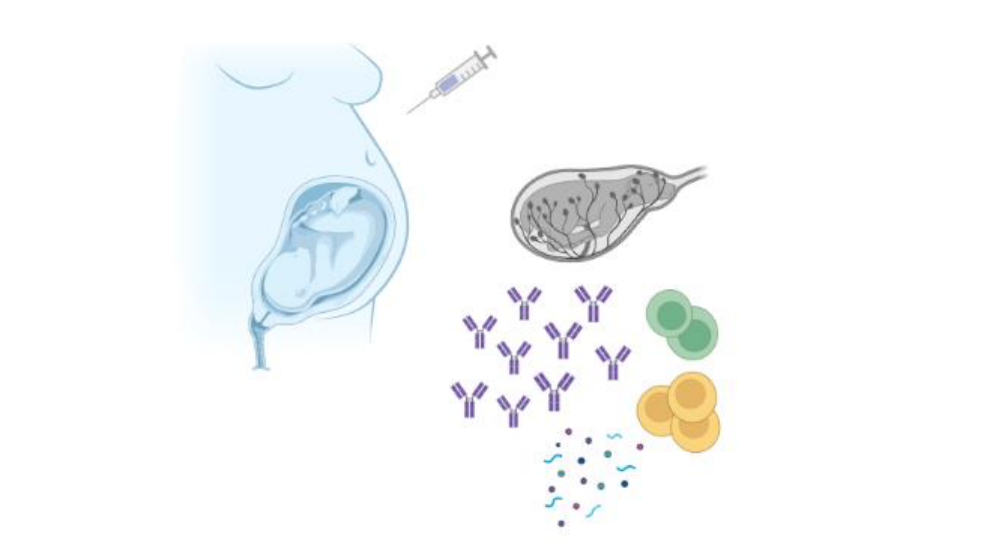
Figure 1. Maternal vaccination may influence the fetal immune system beyond passive transplacental transfer of vaccine-specific antibodies. Evidence suggests that vaccination during pregnancy could prime fetal B cells and T cells. The role of cytokines is currently under investigation. Created with BioRender.com.